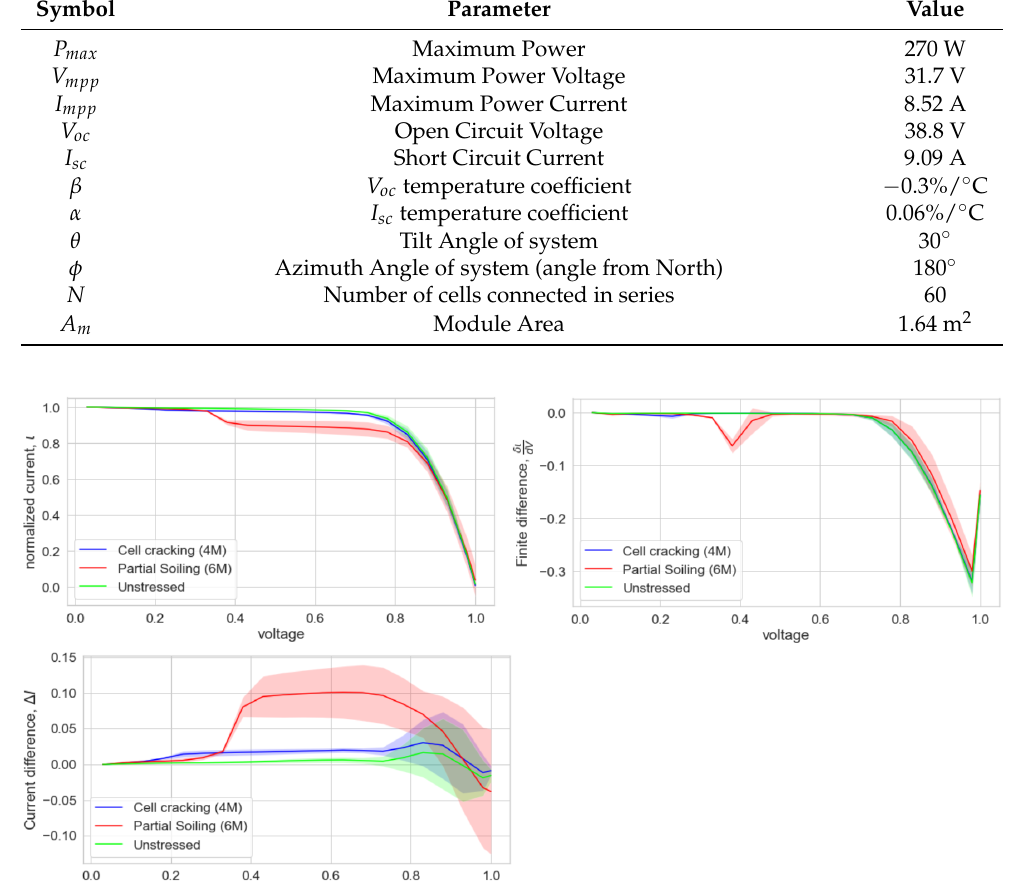
Figure 3. Four features are passed into the neural network (i.e., current, power, current difference, and finite difference), all of which are plotted here against voltage (except power). The normalized current on the top plot clearly shows the partial soiling signal (in red). Similarly, the finite difference represents the derivative of the current with respect to voltage; the plot (middle plot) clearly shows the partial soiling signal. The current differential (bottom plot) calculates the difference between the current from an unstressed simulation and the sample, providing a signal that helps discriminate between the cell cracking and unstressed signals. The data visualized here comes from string-level IV curves from the Florida Solar Energy Center (FSEC), which has known faults applied (see data description in Section